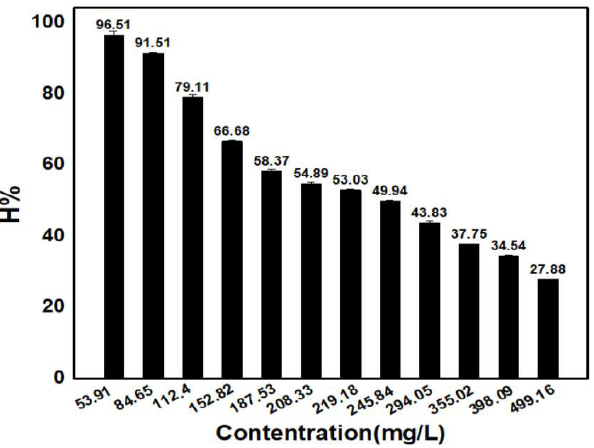
Figure 8. The effects of initial adsorbents concentration on MB adsorption efficiency.